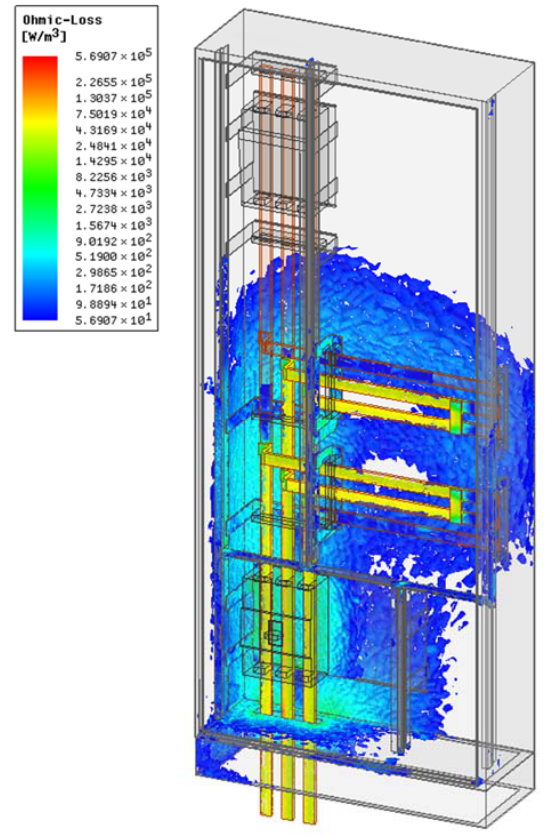
Figure 6. Ohm’s loss distribution presented on a logarithmic scale in the switchgear.